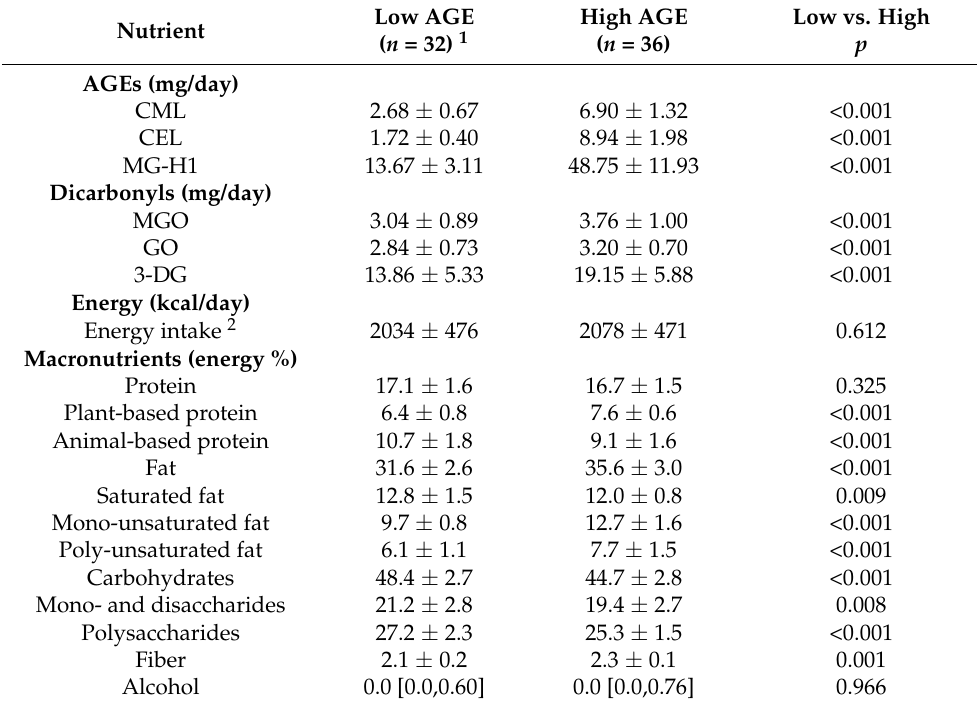
Table 2. Average daily AGE, dicarbonyl, energy, and macronutrient intake of 70 abdominally obese individuals during the low- or high-AGE dietary intervention.